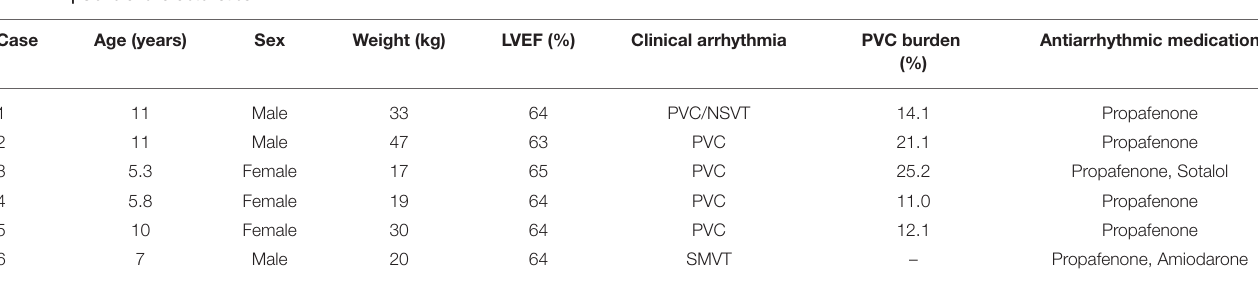
TABLE 1 | General